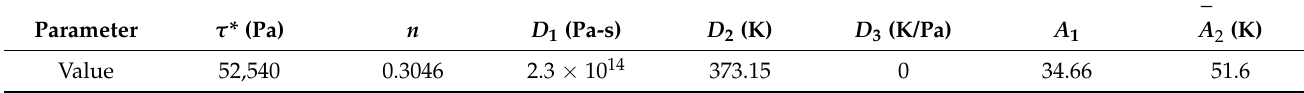
Table 1. Parameters of Cross-WLF viscosity model for ABS.